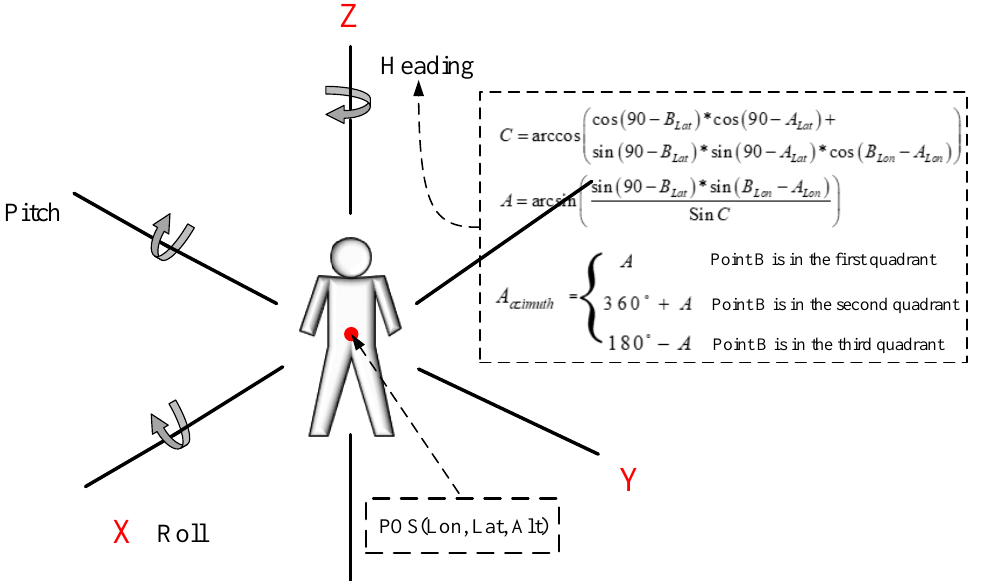
Figure 5. Spatial position and orientation.